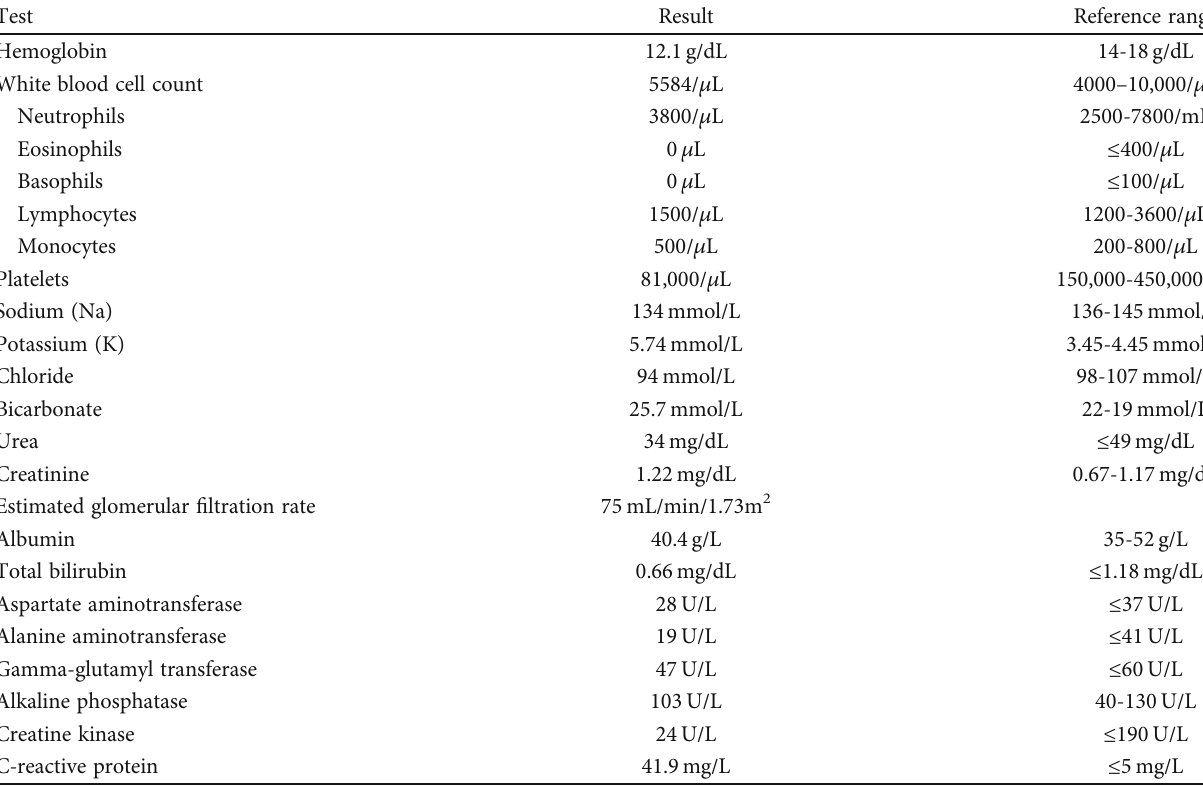
Table 2: Laboratory results in the emergency